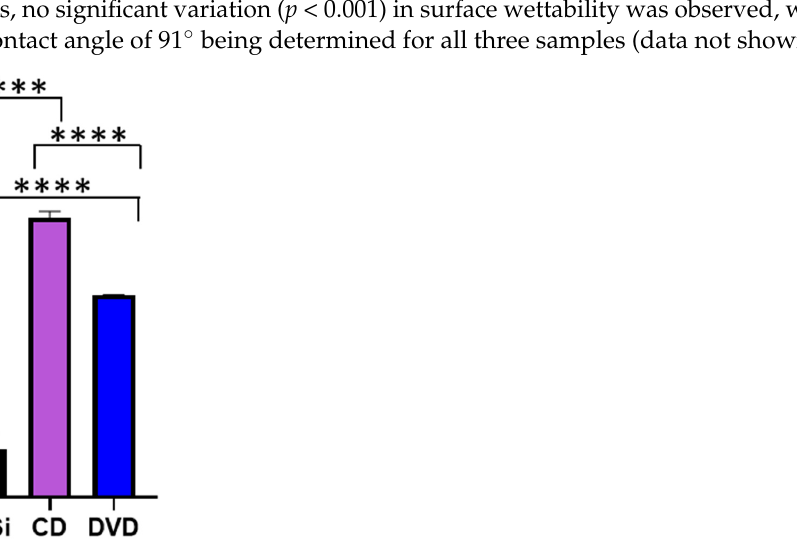
Figure 3. Atomic force microscopy (AFM) images of ( a ) Ti-coated CD surface and ( b ) Ti-coated DVD surface.